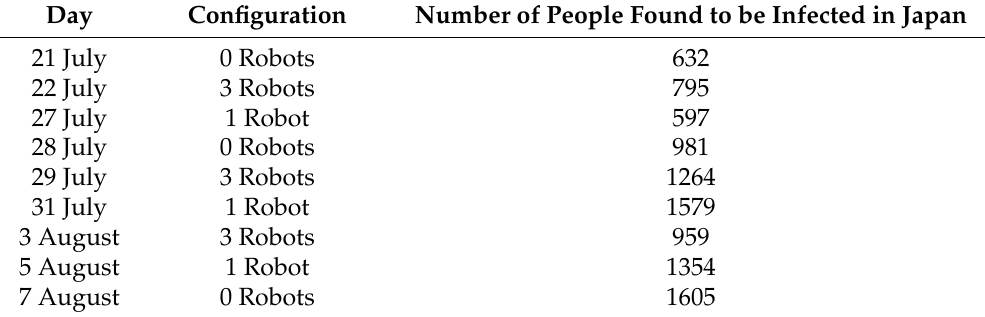
Table 1. Configuration of the experimental setup and the number of people found to be infected by COVID-19 on each day of the